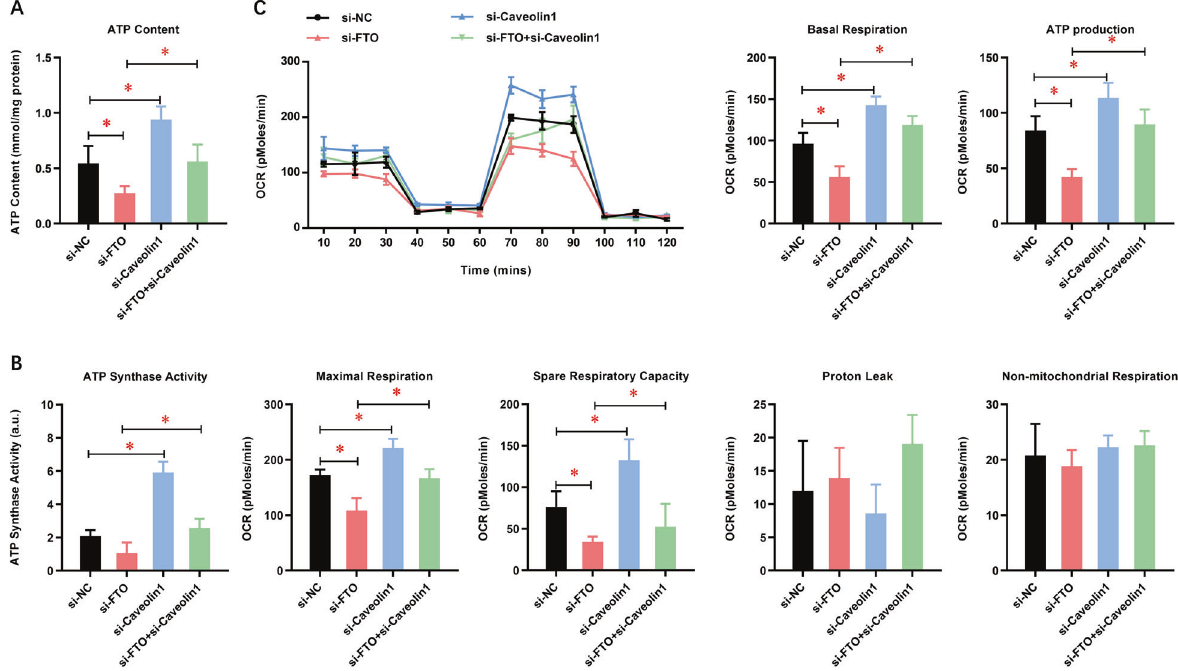
Fig. 6 FTO depletion impairs the mitochondrial metabolism of GC cells via caveolin-1. A The effect of caveolin-1 depletion on the ATP content of AGS and SGC-7901 cells with or without FTO depletion was analyzed. B The effect of caveolin-1 depletion on the ATP synthase activity of AGS and SGC-7901 cells with or without FTO depletion was analyzed. C The effects of FTO and caveolin-1 on mitochondrial respiration (OXPHOS) were tested using the Seahorse XF24 Extracellular Flux Analyzer. N = 3, * p < 0.05, ** p < 0.01 compared with the indicated